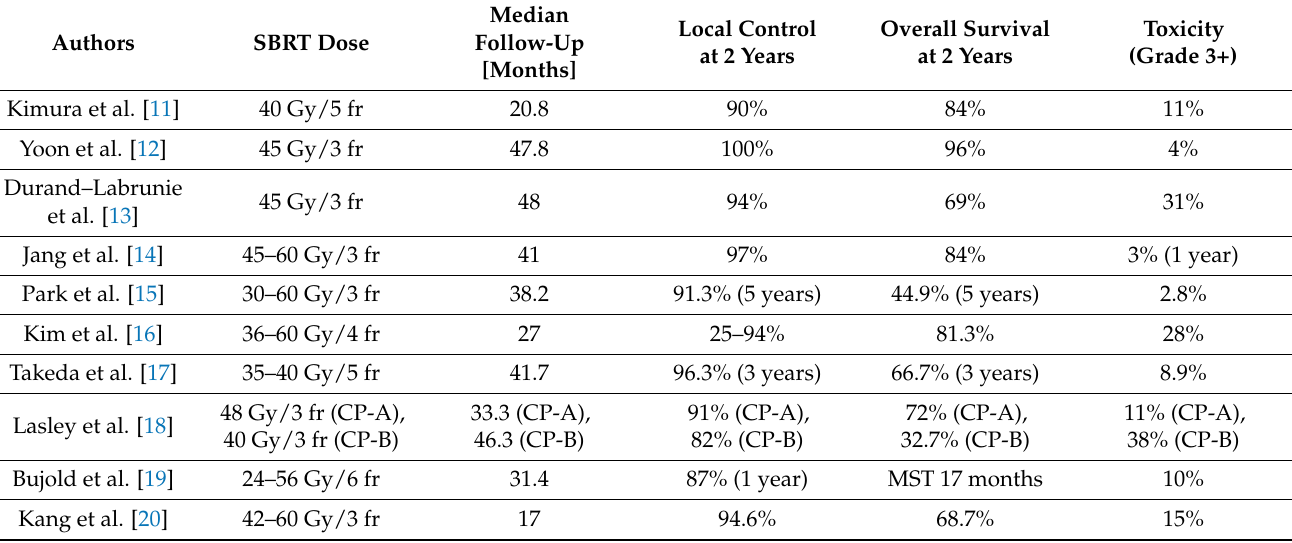
Table 2. Clinical outcomes of the studies depicted in Table